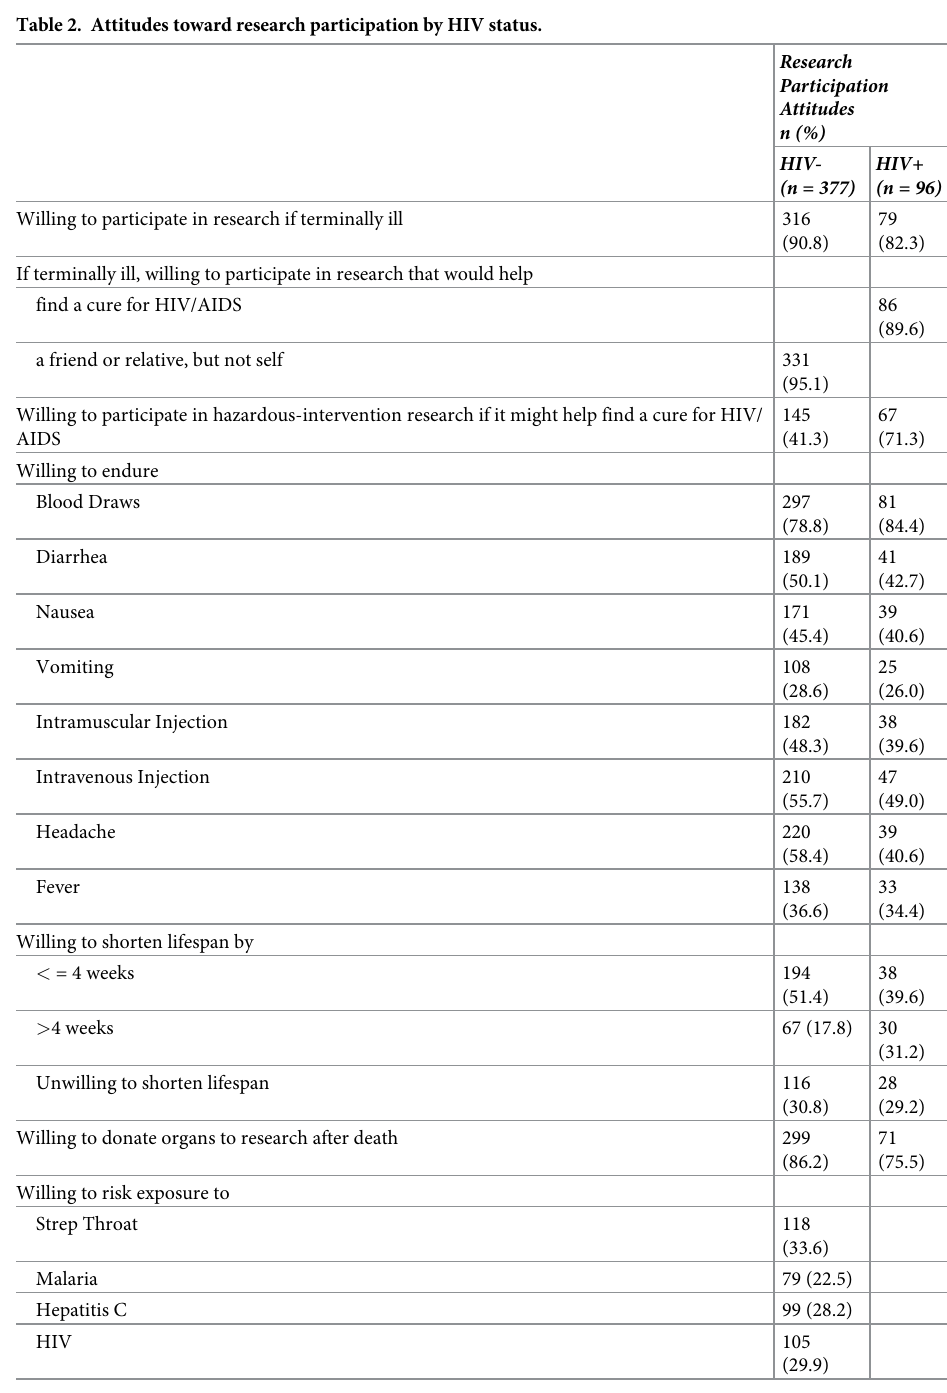
Table 2. Attitudes toward research participation by HIV